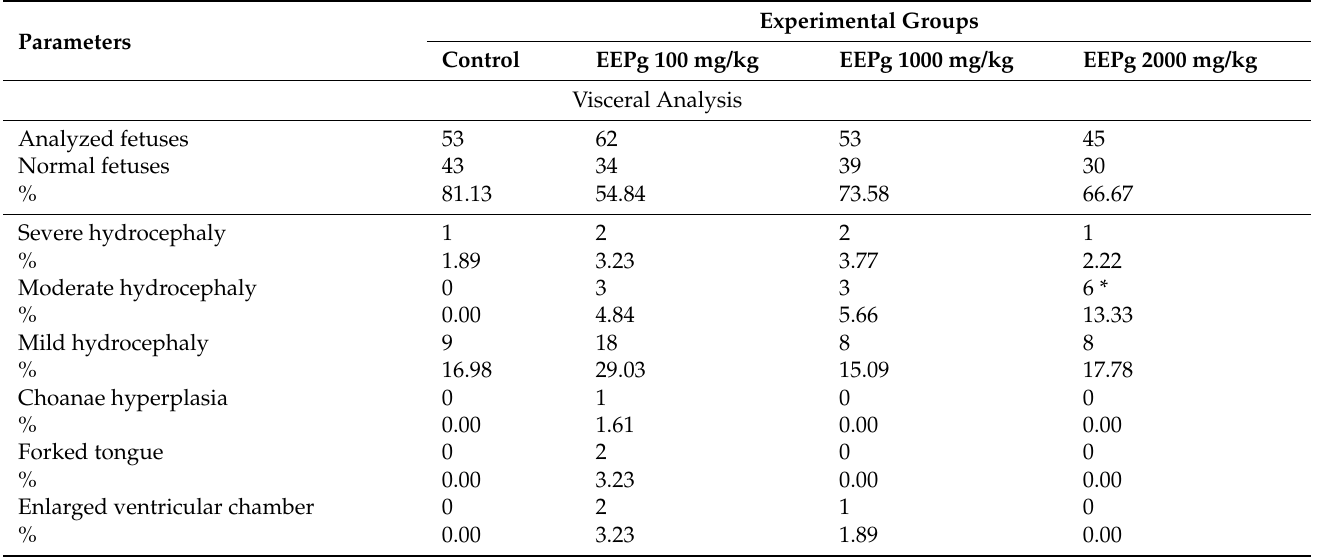
Table 6. Absolute number and percentage of visceral malformations found in the offspring of females treated with the ethanolic extract of P. glabratum